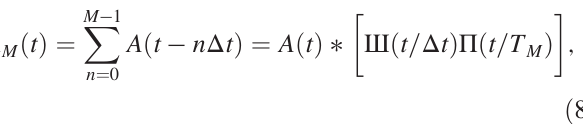
˜ A ν Þ , vs cavity M ð